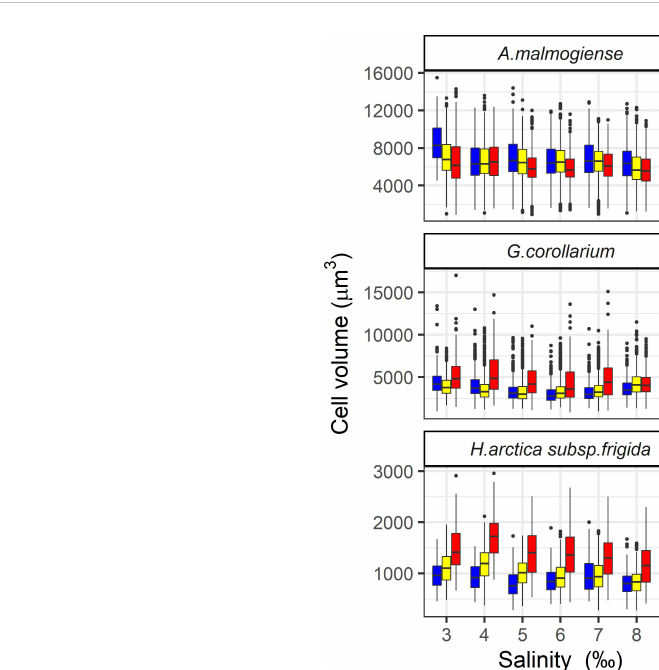
None of the three dino fl agellates grew in all treatments and the highest observed growth rates across all experiments were 0.38,